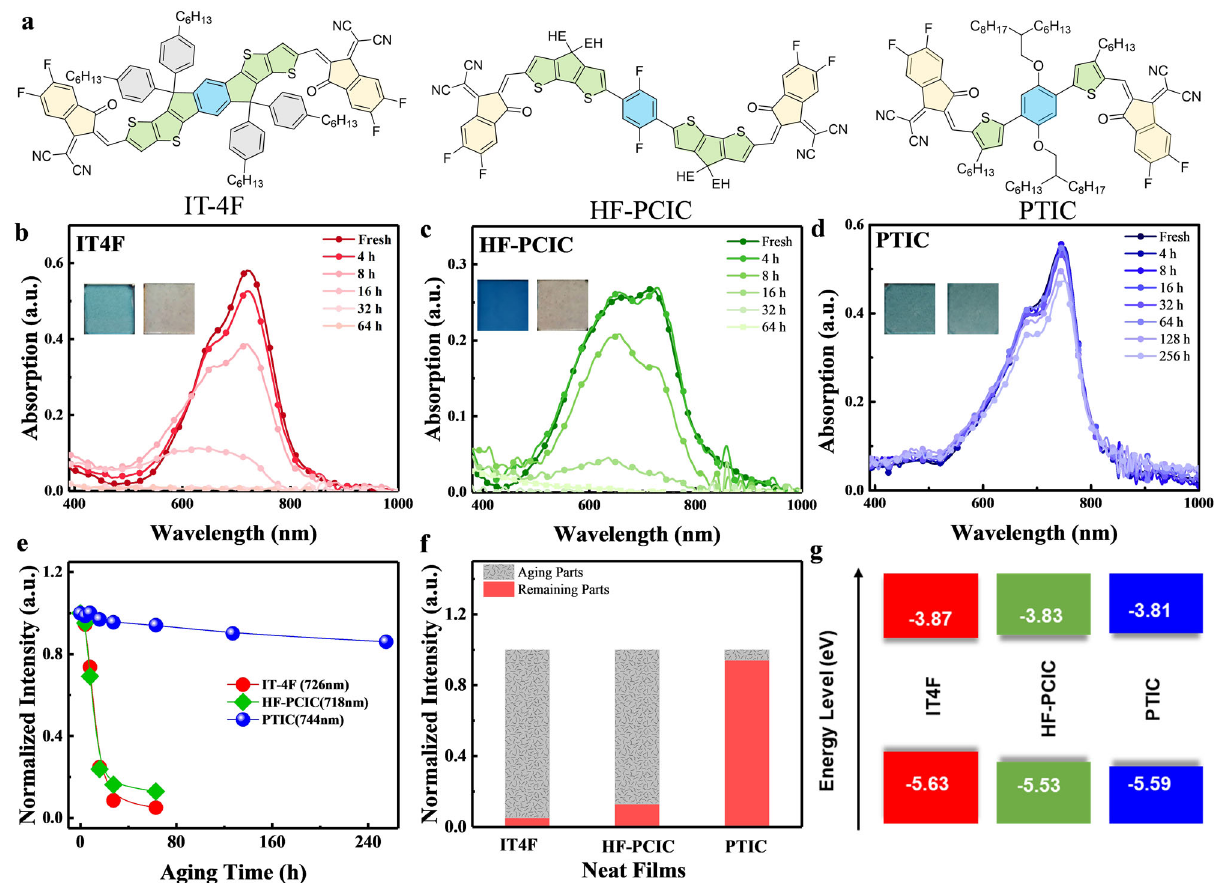
Fig. 2 Intrinsic photostabilities of A – D – A NFAs. a Molecular structures of FREA IT-4F, SFRA HF-PCIC, and NFRA PTIC. b – d Their fi lm UV – vis absorption spectra and photo images (before and after 64 h) under one-sun-equivalent illumination in ambient. e The change and f , the percentage of remaining absorption intensity at 64 h illumination. g Energy levels for different acceptors. EH